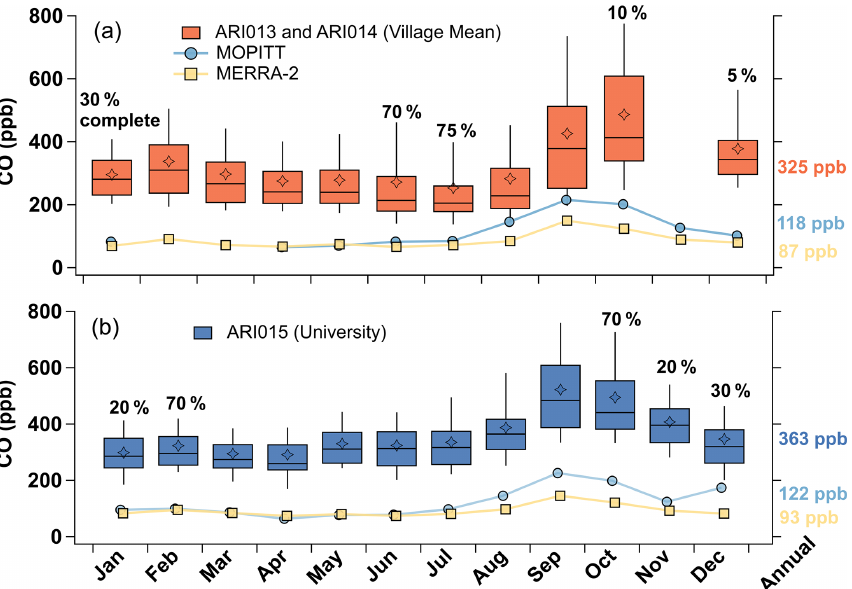
Figure 8. Monthly carbon monoxide (CO) concentration (ppb) reported by the surface ARISense (Tukey boxplots) and remote sensing data products (lines and markers indicating mean monthly value) at the (a) Village Mean and (b) University sites. The tops and bottoms of the boxes indicate 75th and 25th percentiles, whiskers show the 9th and 91st percentiles, the middle line indicates the median, and stars indicate mean. The ARISense surface data were at least 80% complete for each month, except where noted with a percentage text label. Data for July 2017 and July 2018 were averaged. Village Mean represents the average of ARI014 (Village 1) and ARI013 (Village 2) data. The annual mean from each data source is given on the right axis. MOPITT (multispectral CO surface mixing ratio daytime / descending) is a satellite measurement, and MERRA-2 (CO surface concentration ENSEMBLE) is a global reanalysis